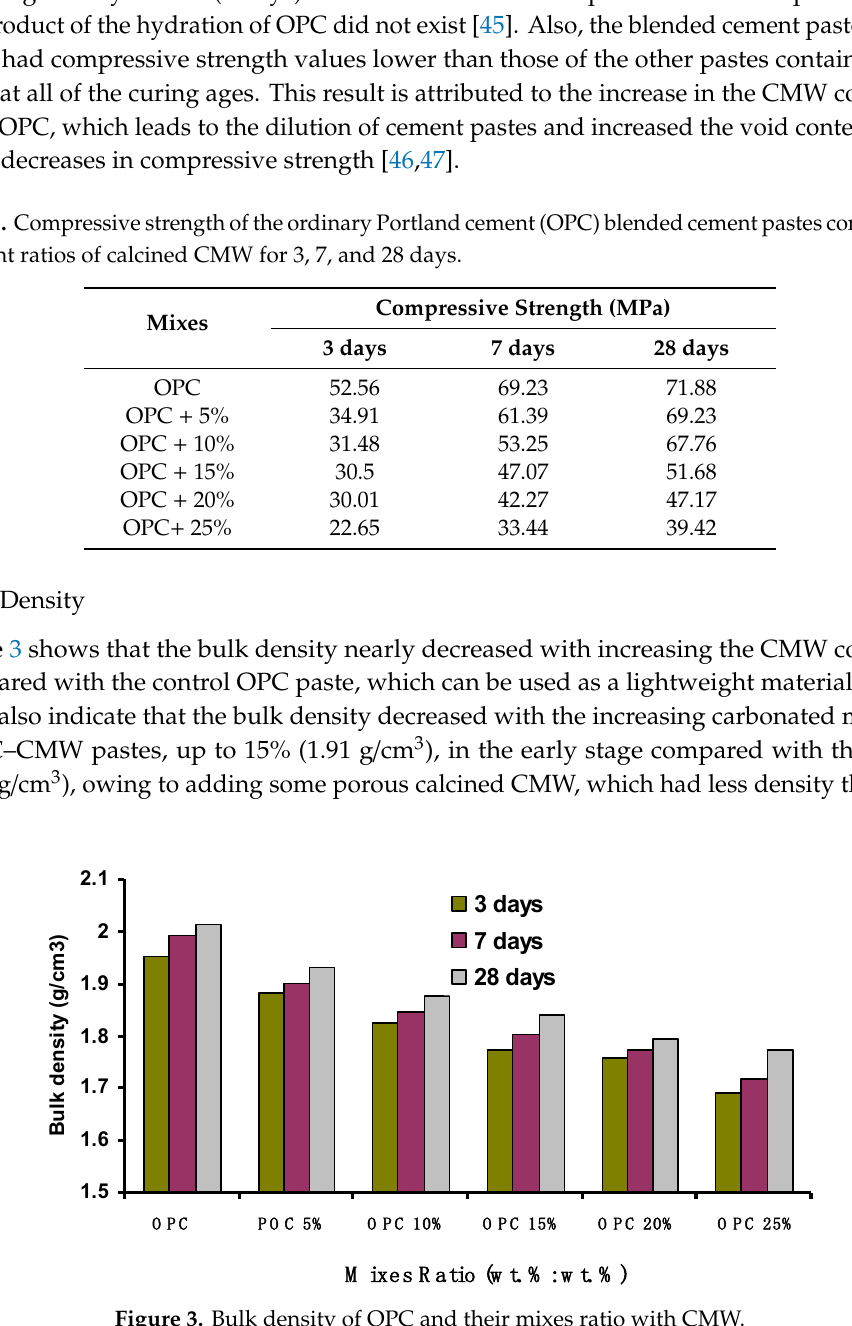
Table 3. Compressive strength of the ordinary Portland cement (OPC) blended cement pastes containing different ratios of calcined CMW for 3, 7, and 28 days.